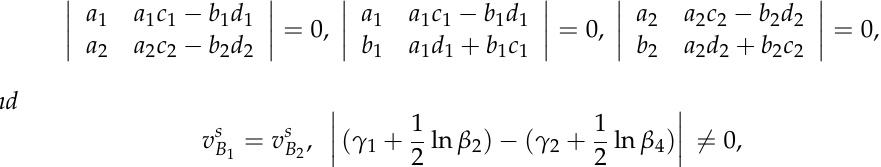
, f 2 = − 5.559, γ 2 = − 10. ( a – c ) 3